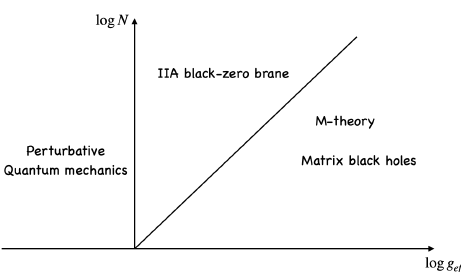
Figure 2. A cartoon for the phases of the matrix model in the large N limit based on [2]. The horizontal axis can be expressed via g e ff = λ in the microcanonical ensemble and via g e ff = λ E 3 ensemble. The type IIA black-zero brane phase is valid for temperatures in the range (7). When this upper bound is exceeded, we transition to the M-theory